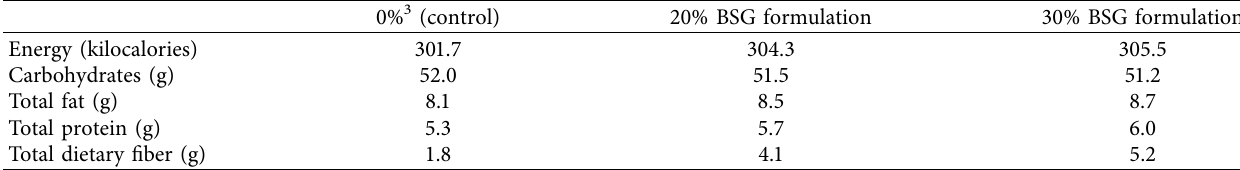
Table 2: Nutritional analysis 1 per serving 2 of control and brewers’ spent grain (BSG) muffins.